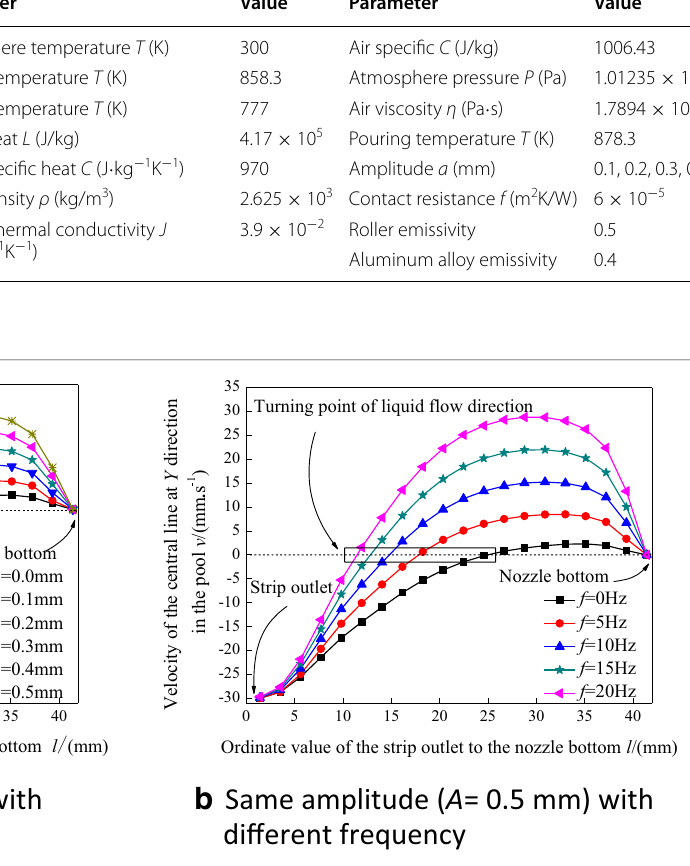
Figure 2 Velocity of the central line in Y direction in the pool at the position of rising